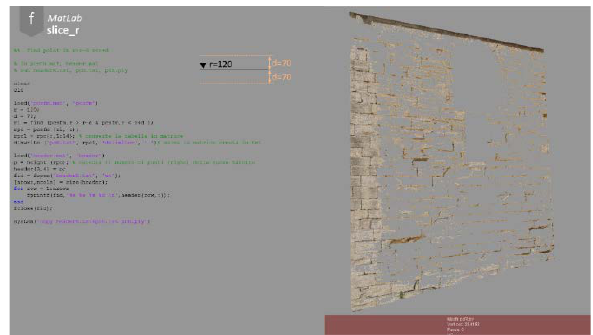
Figure 17. Selection of point cloud, starting from a given value of r (red) and a selectable range.